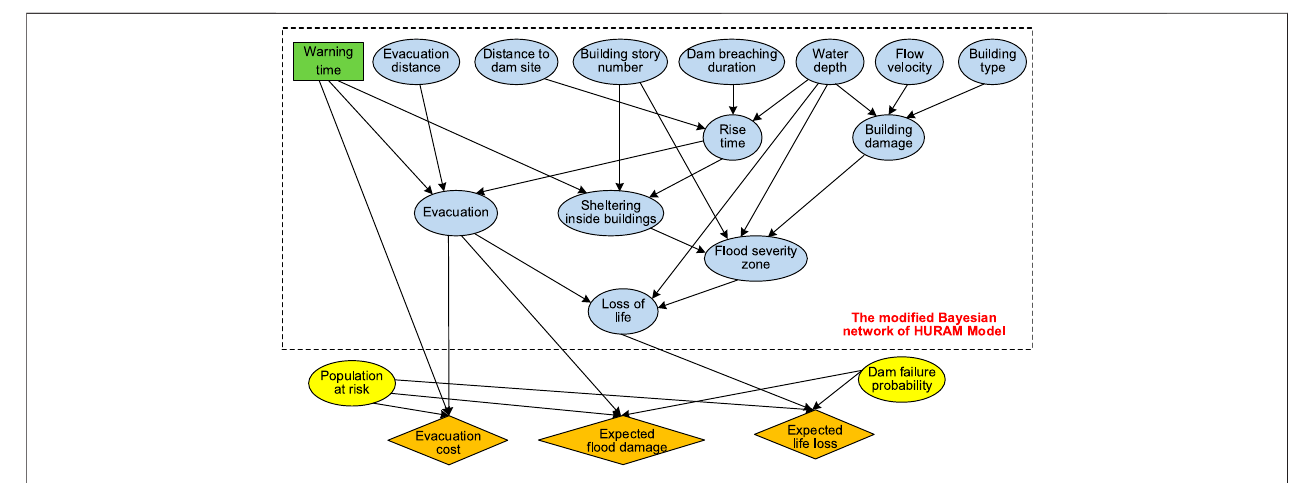
FIGURE 4 | The decision-making model based on In fl uence